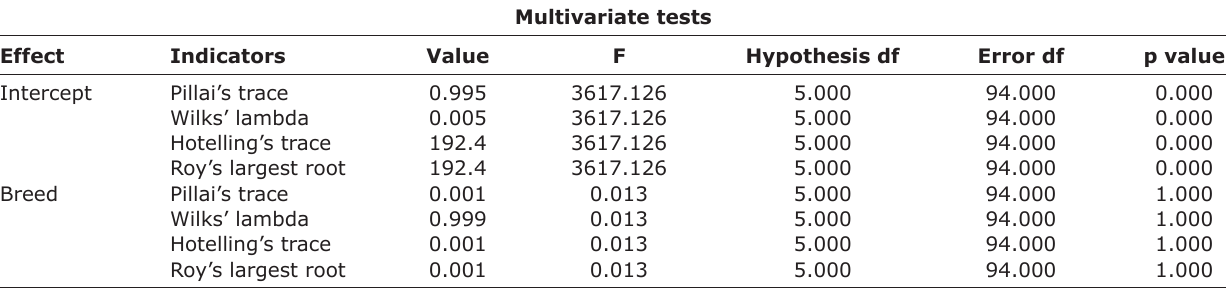
Table-4: One-way MANOVA for testing the effect of breed on the performance traits.